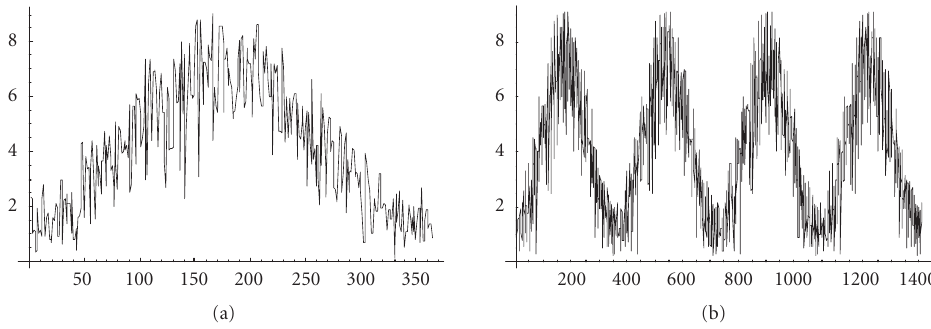
Figure 6: (a) Solar radiation data (kWh) measured in Serres (Greece) for one year, (b) solar radiation values simulated for Serres (Greece) for a period of 4 years.